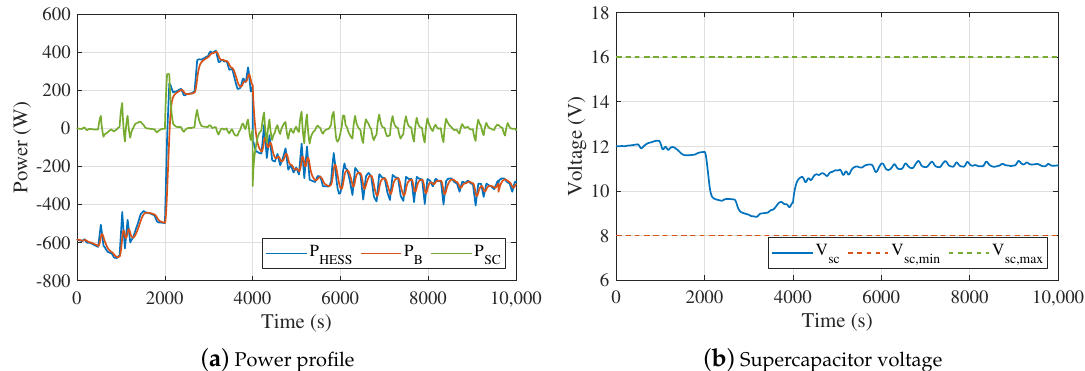
Figure 4. Power filtering and voltage results for the HESS with a first-order low-pass filter (LPF) ( T = 50